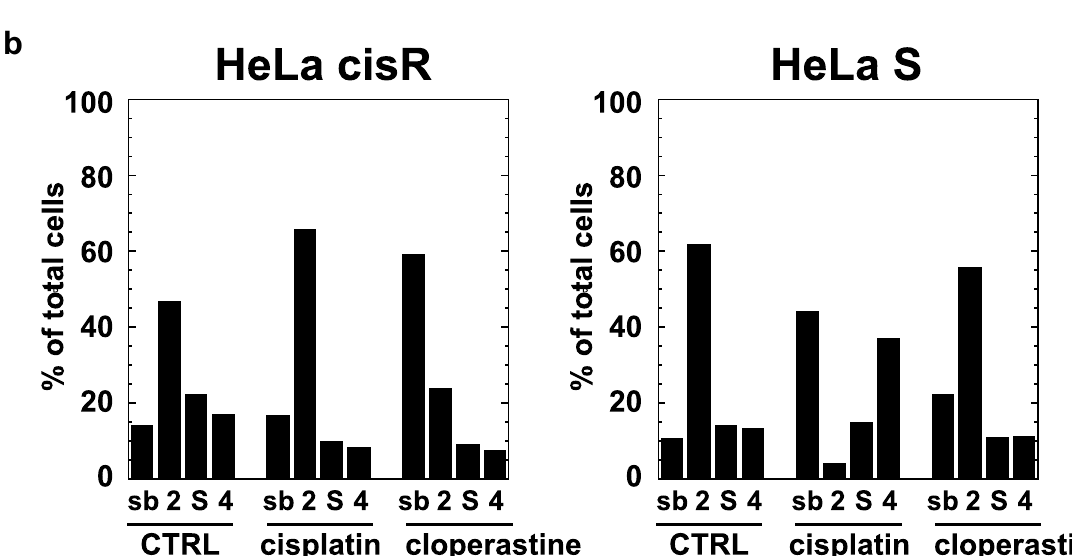
Figure 6. Cloperastine increases the HeLa cisR cell fraction in sub G1 phase. ( a ) Flow cytometric analysis of the cell cycle. Growing HeLa cisR and HeLa S cells were cultured for 3 days in their respective growth media (control) or in medium containing 1 µg/ml cisplatin or 100 µM cloperastine. The cells were then fixed, the cellular DNA stained with propidium iodide (PI), and the fluorescence intensity and frequency analyzed using a flow cytometer and plotted. Arrowheads and brackets indicate sub G1 phase ( sb ), G1 phase ( 2n ), S phase ( S ), and G2/M phase ( 4n ) for each cell line and treatment. Two separate experiments yielded essentially the same results. ( b ) Relative cell numbers in each cell cycle phase in panel a were quantified using ImageJ software and plotted as percentages of the total cells. The labels indicate sub G1 phase ( sb ), G1 phase ( 2 ), S phase ( S ), and G2/M phase ( 4 ) for each cell line and